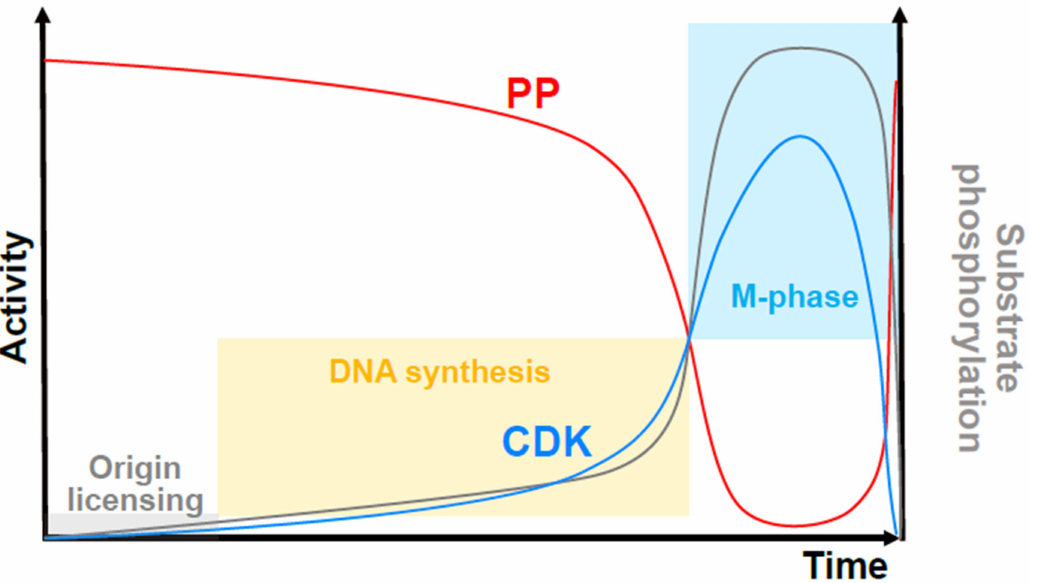
Figure 3. An updated quantitative model of cell cycle control by the CDK/phosphatase activity ratio. Overall CDK activity (blue curve) competes with protein phosphatase (PP) activity (red curve) to the phosphorylate substrates (grey curve shows the level of substrate phosphorylation). When substrate phosphorylation is very low (grey shaded box), DNA replication origins can be assembled (origin “licensing”). Increased phosphorylation promotes origin activation and DNA synthesis (yellow shaded box) but high levels, which are attained in a switch-like manner at a threshold of CDK to PP activity, prevent replication, and trigger mitosis (blue shaded box). The level of CDK activity required for mitotic onset is higher than that required to maintain the mitotic